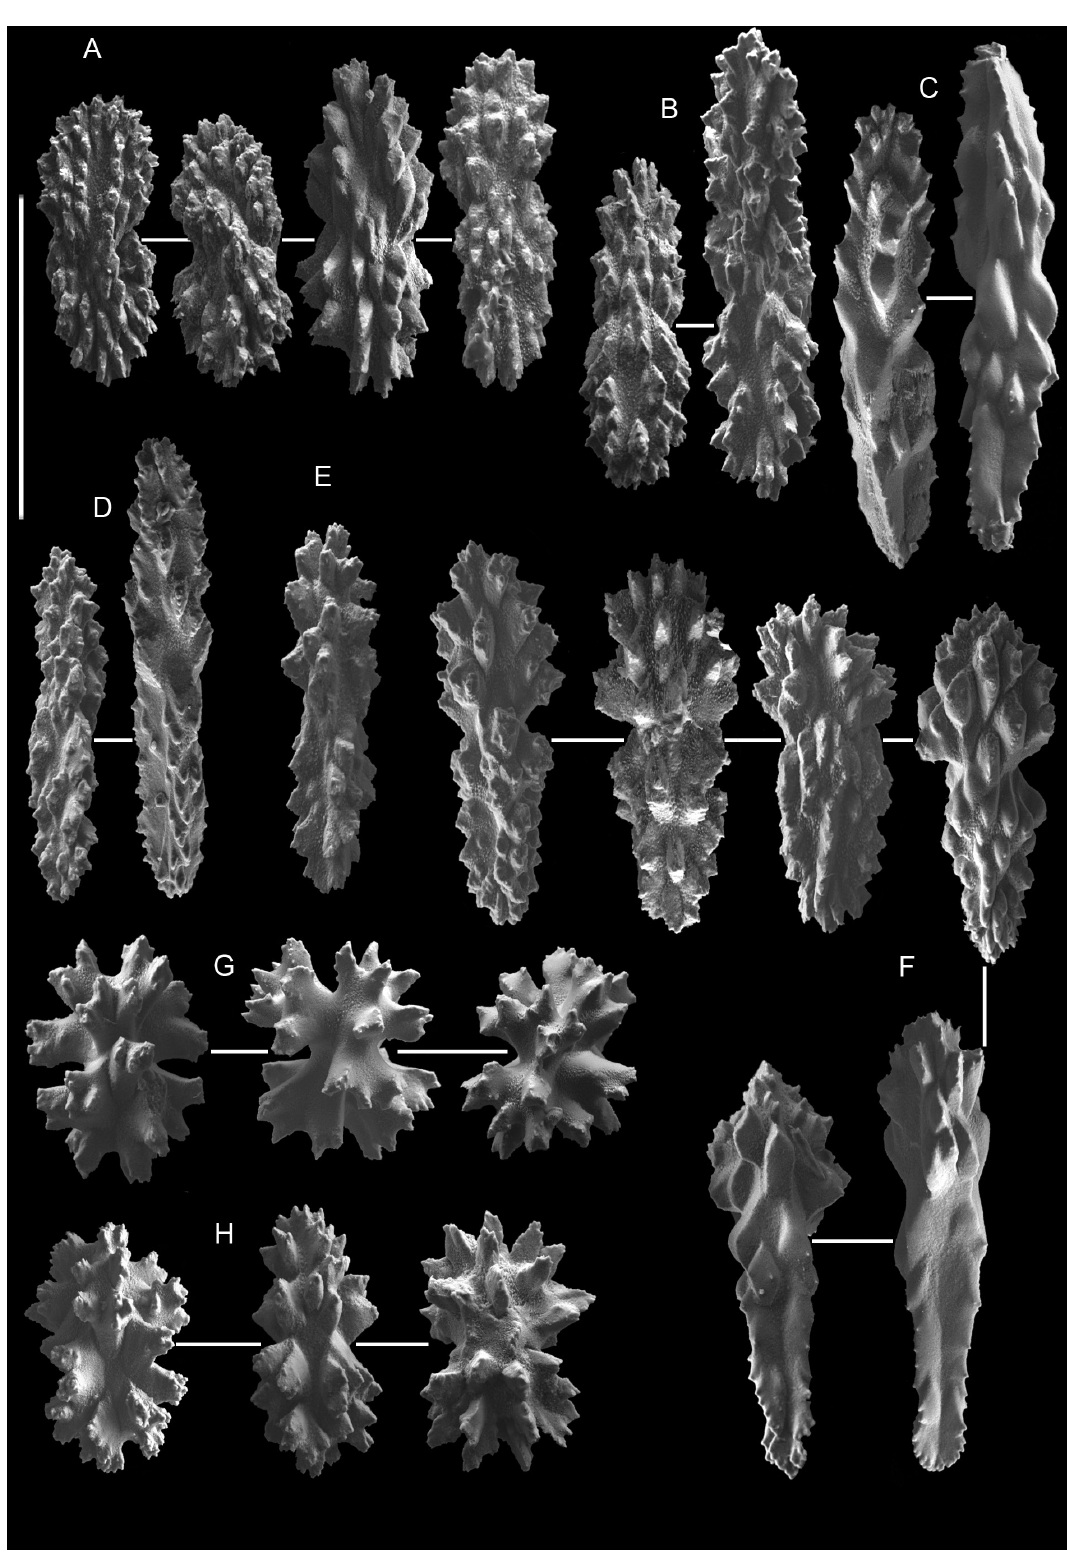
Fig. 4. Heteropolypus annae sp. nov., paratype (MIMB 42494); sclerites from the autozooid tentacles. A . Waisted plates. B . Plates. C . Flanged spindles. D . Warty spindles. E . Club-like spindle. F . Clubs. G . Capstans. H . Slender capstans. Scale bar = 0.1